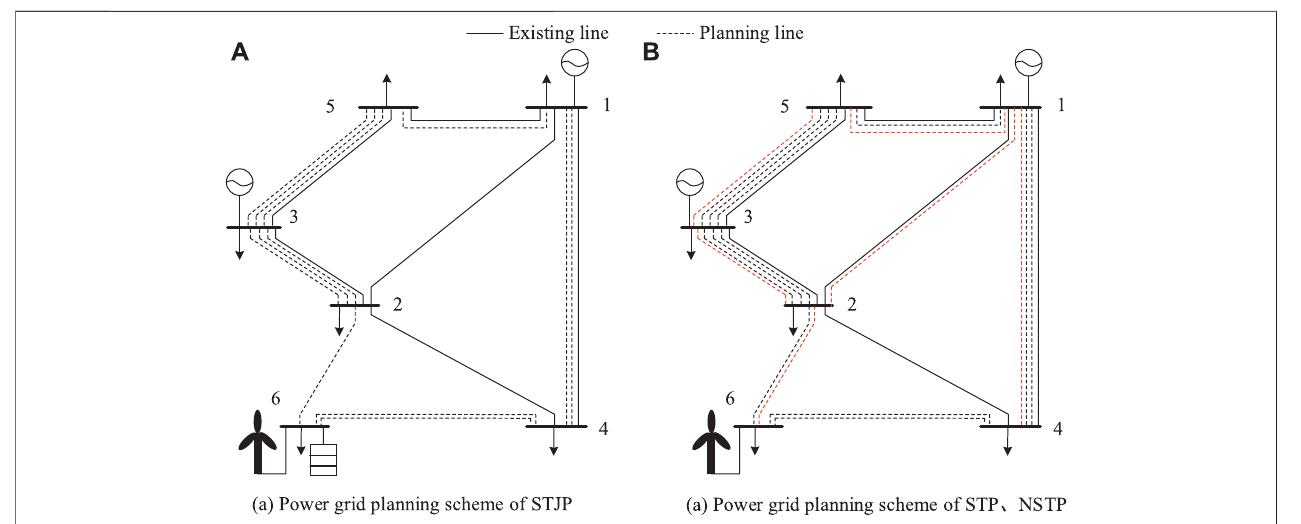
FIGURE 10 | Power grid planning